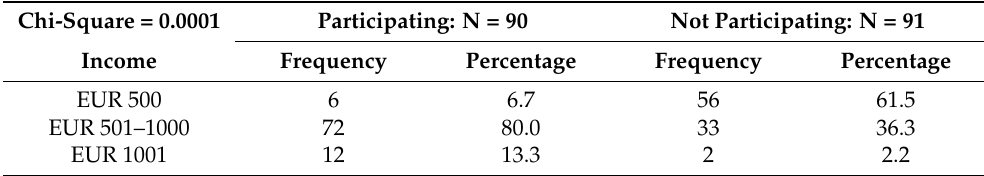
Table 1. Source of family income as a function of participation in the educational